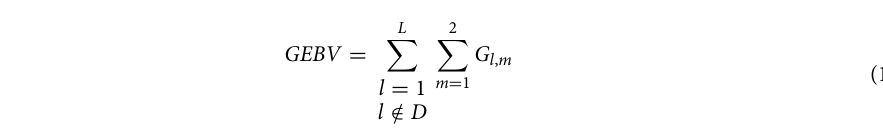
According to this approach, the positive individuals with highest GEBVs will be selected as parents. Predicted cross value selection. The predicted cross value (PCV) calculates the probability that a pair of breed- ing parents will produce a gamete with desirable alleles at all specified loci by taking into account the recombi- nation frequencies 30 . This approach selects individuals based on their likelihood to produce an elite gamete by combining all desirable alleles. Since in a backcrossing scheme, individuals are always crossed with the recurrent parent, the PCV can be defined as the probability that each individual will produce an elite gamete. Let g ∈ B L × 1 denote a random gamete produced by a breeding parent. The PCV of an individual is calculated as follows: